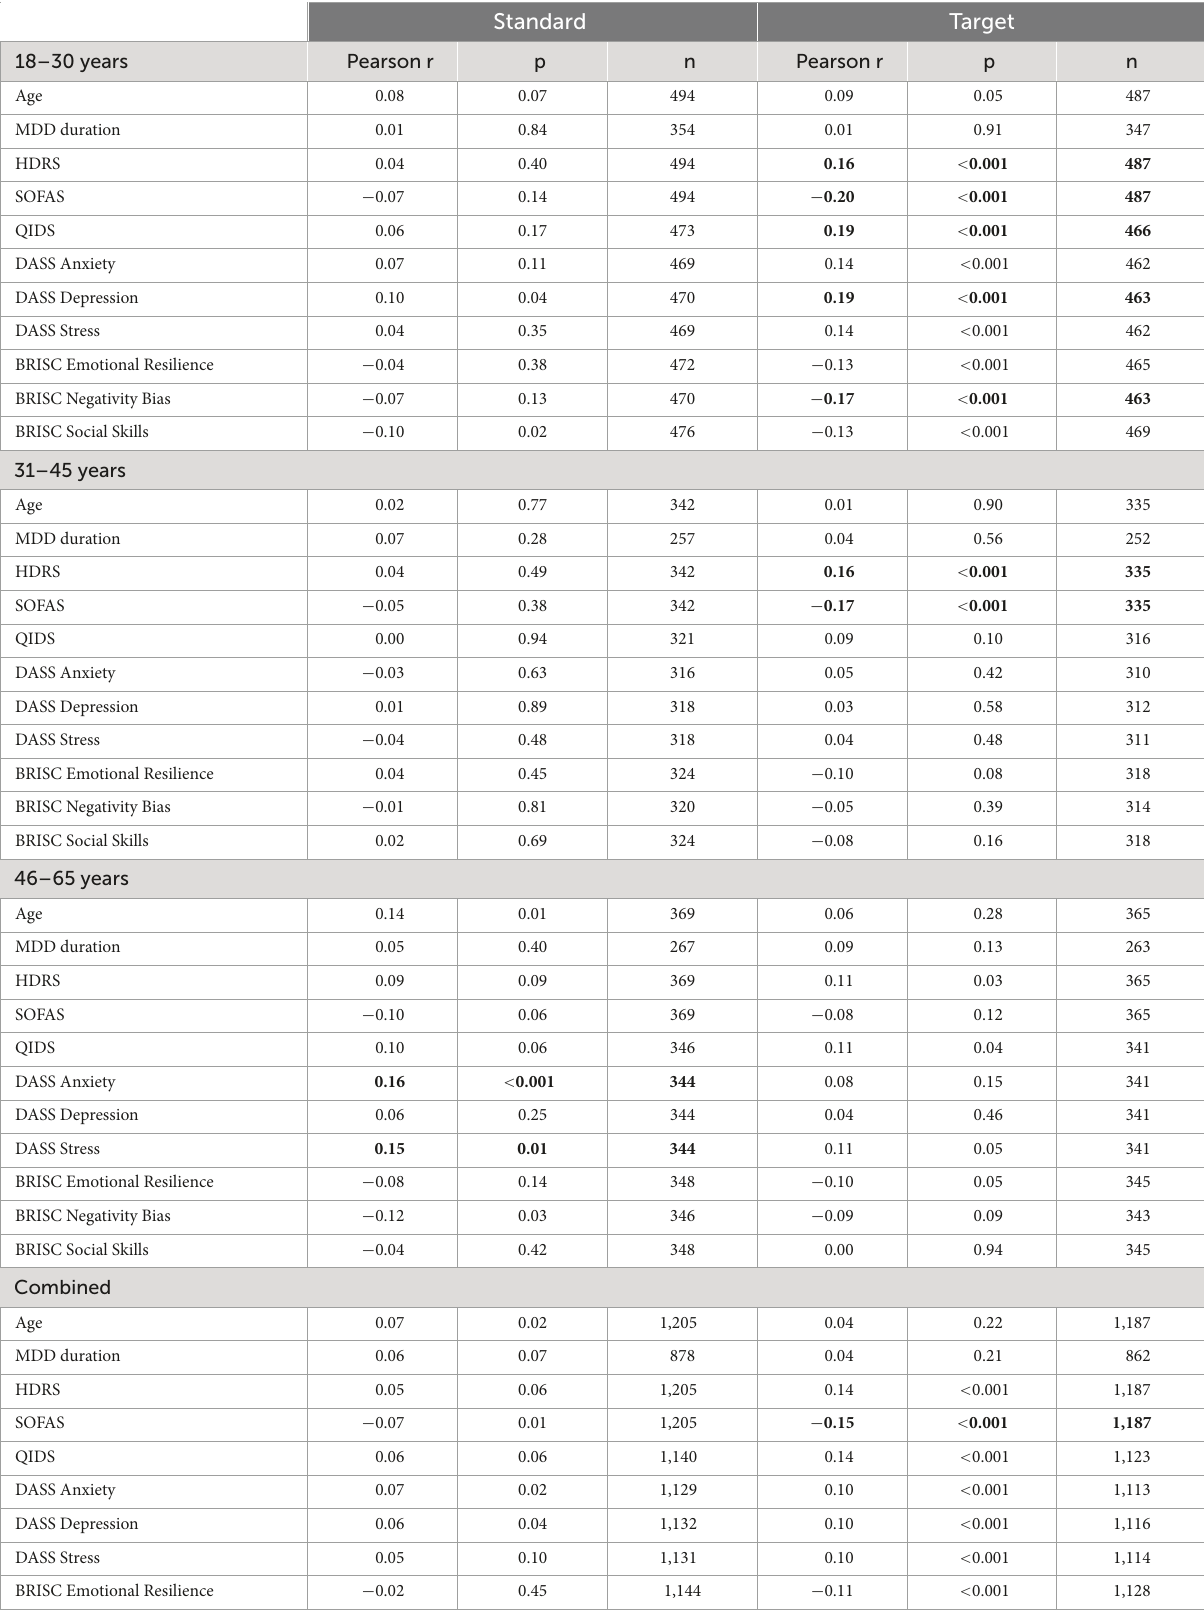
TABLE 2 Correlations between the N1 amplitude at the Cz location in response to standard and target sounds and behavioral